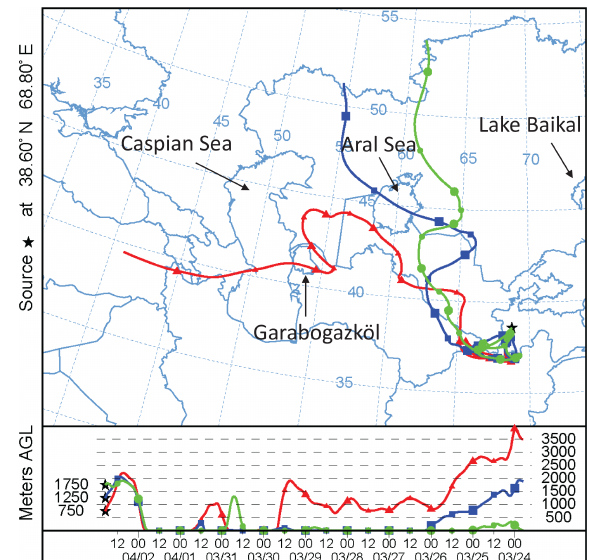
Figure 12. 10d backward trajectories arriving at Dushanbe, Tajik- istan, at 750m (red), 1250m (blue), and 1750m height on 2 April 2015, 19:00UTC. The HYSPLIT model (Hybrid Single Particle Lagrangian Integrated Trajectory Model) (HYSPLIT, 2020; Stein et al., 2015; Rolph, 2016) is applied. Different sources of di- rect salt dust emissions are indicated. The right half of the Aral Sea is the Aralkum